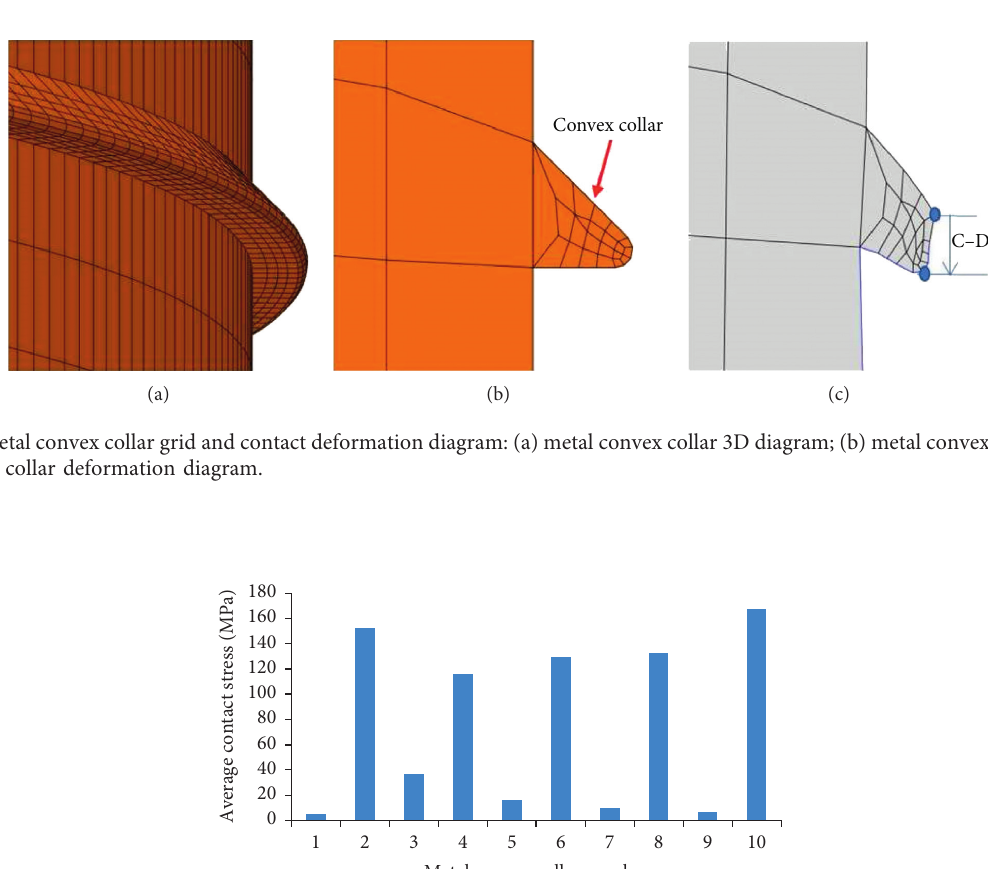
Figure 16: Hang force generated by each rubber cylinder.